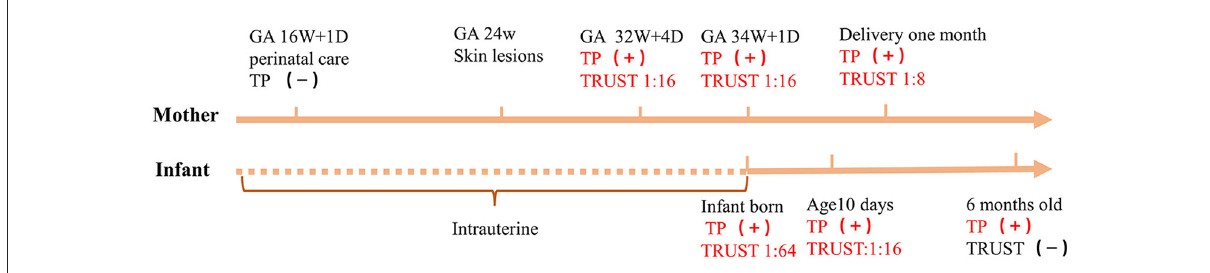
FIGURE1 Timeline of the newborn and his mother. + , indicates a positive result; − , indicates a negative result; TP, treponemal serological test; GA, gestational age; 16W + 1D = 16 weeks 1/7 days, 32W + 4D = 32 weeks 4/7 days, 34W + 1D = 34 weeks 1/7